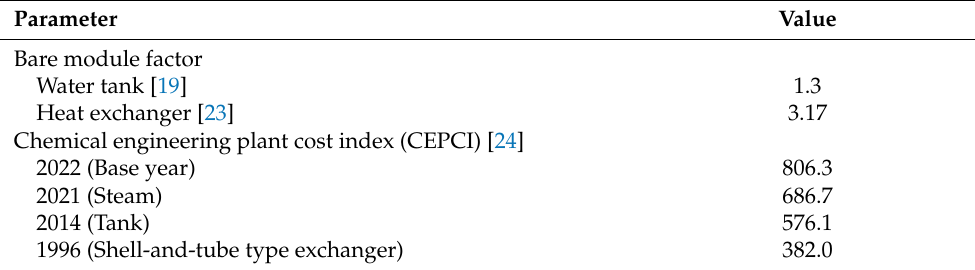
Table 10. Cost parameters for the economic